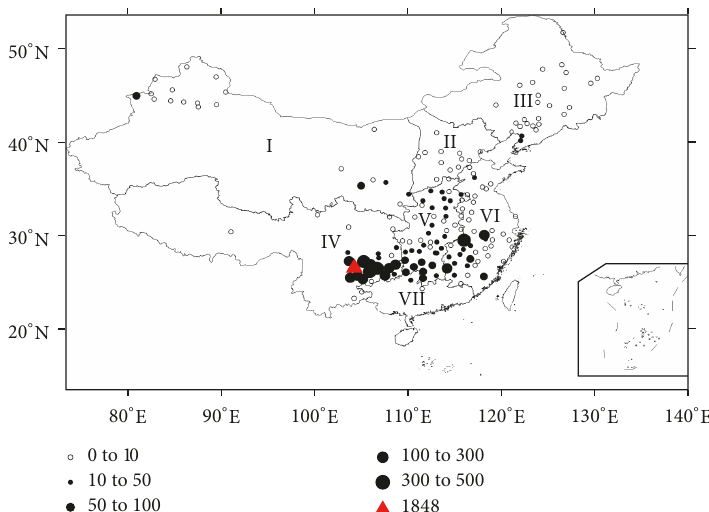
Figure1:DistributionoffreezingrainsinChinafrom2000to2015(unit:station-hour):(I)NorthwestChina;(II)NorthChina;(III)Northeast China; (IV) Southwest China; (V) Central China; (VI) East China; (VII) South